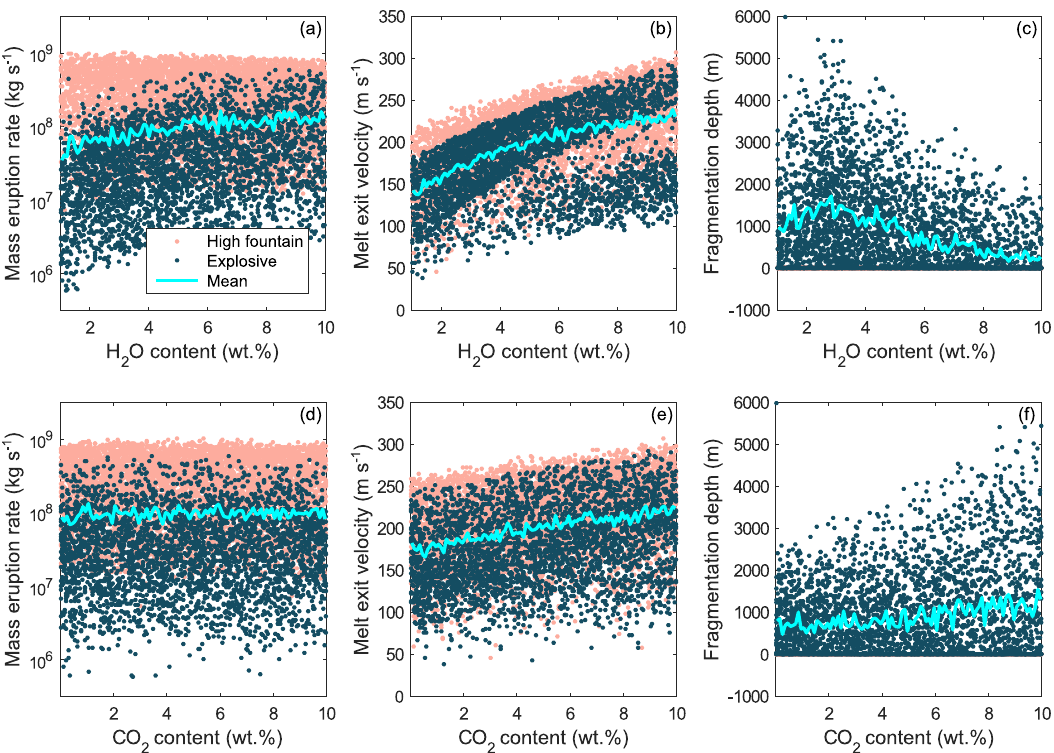
Fig. 5 Correlation plots of selected output parameters as function of each volatile content obtained from the sensitivity analysis. We illustrate the mass eruption rate as function of ( a ) H 2 O and ( d ) CO 2 , the melt/particle exit velocity as function of ( b ) H 2 O and ( e ) CO 2 , and the fragmentation depth as function of ( c ) H 2 O and ( f ) CO 2 . Each point (dark green for an explosive simulation and pink for a high fountains one) represents one of the 10,000 simulations from the sensitivity analysis. The cyan line is the mean of the output values at a given input value.